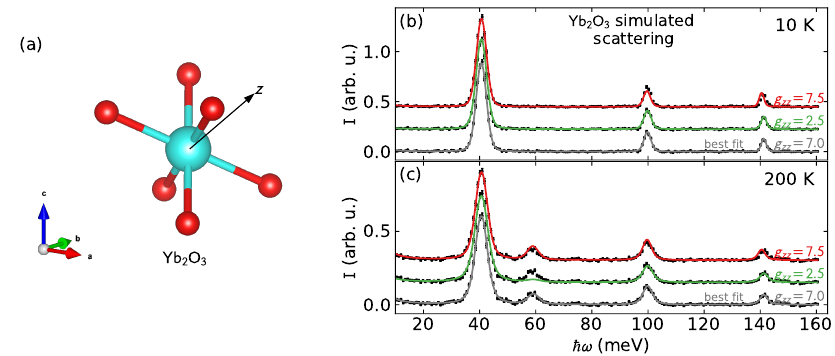
Figure 5: Yb O simulated scattering and fits. (a) shows the crystal structure of 2 3 Yb O . (b) and (c) show the point charge model simulated scattering at 10 K and 2 3 200 K, respectively. The three curves show three fits: the bottom (grey) shows the original model and best fit, the middle (green) shows the minimum g top (red) shows the maximum g zz